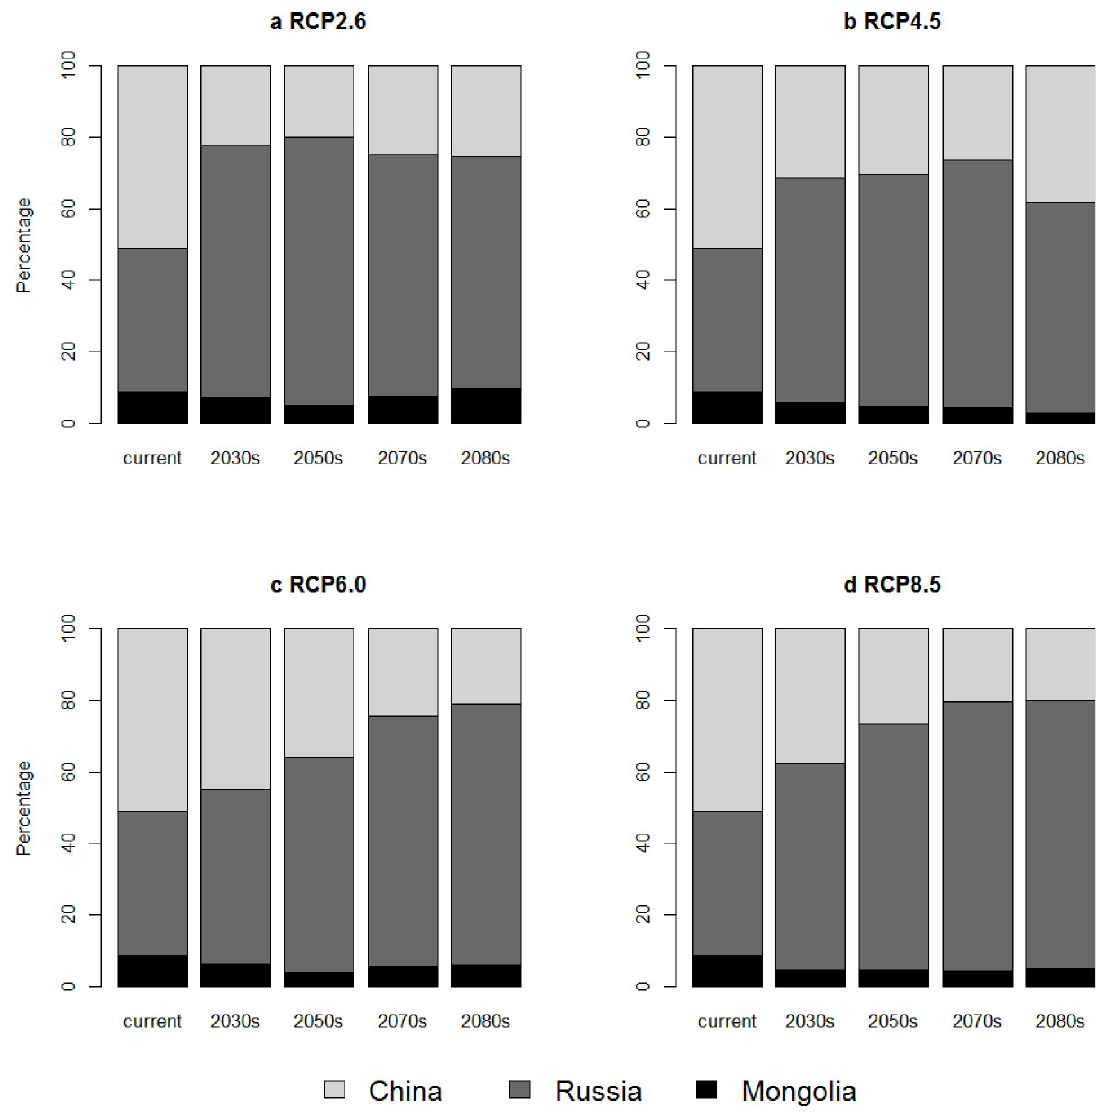
Fig 4. Proportion of breeding area in China, Russia and Mongolia. a. low emission scenario–RCP2.6, b. intermediate scenario– RCP4.5, c. intermediate scenario–RCP6.0, d. high emission scenario–RCP8.5. We also calculated the proportion of grid cells predicted to be breeding area in the current actual breeding range of the red-crowned crane. The results show that the predicted grid cells suitable for breeding area in current actual breeding range from our model decrease very quickly in the near future under all climate change scenarios (Fig 5). Under the high emission scenario—RCP8.5 and the intermediate emission scenario—RCP6.0, the red-crowned crane would lose almost all of its actual breeding range at the end of this century. The situation is bet- ter under the low emission scenario—RCP2.6 and the intermediate emission scenario— RCP4.5. The continental population of the red-crowned crane would still have approximately 15% of its current actual breeding range at 2080s. At the center of this century, our model pre- dicts the lowest area of suitable breeding area in current actual breeding range under RCP2.6 and RCP4.5. Under the intermediate emission scenario—RCP6.0, the red-crowned crane will